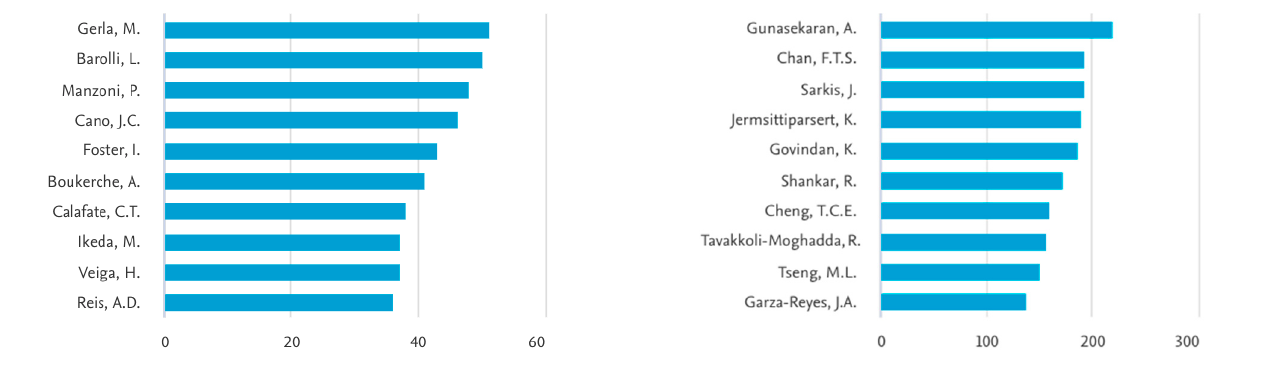
Table 3. Breakdown of the publication by author.